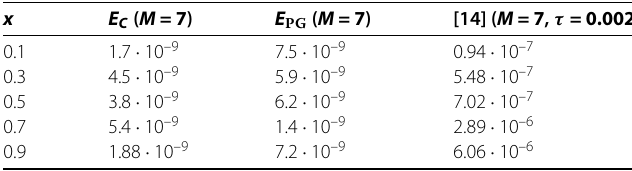
Table 5 Comparison between different errors of Example 3 ( t = 2) x E C ( M = 7